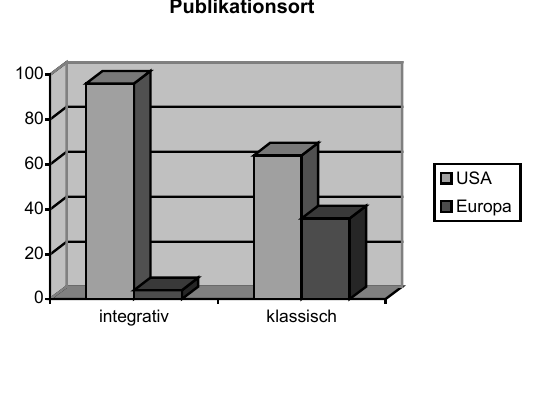
Abbildung 1. Häufigkeit der Evaluationsstudien in Abhängigkeit vom Publikationsort, dem klinisch relevanten Outcome und der Häufigkeit der